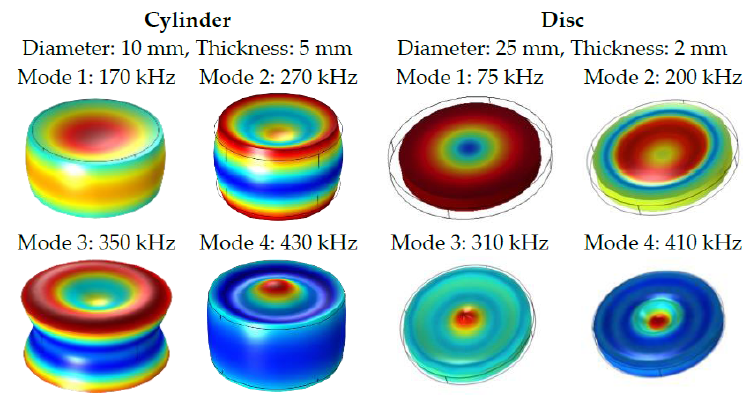
Figure 5. Admittance anti-resonance frequencies of the first four lowest modes for the reference cylinder and disc samples.